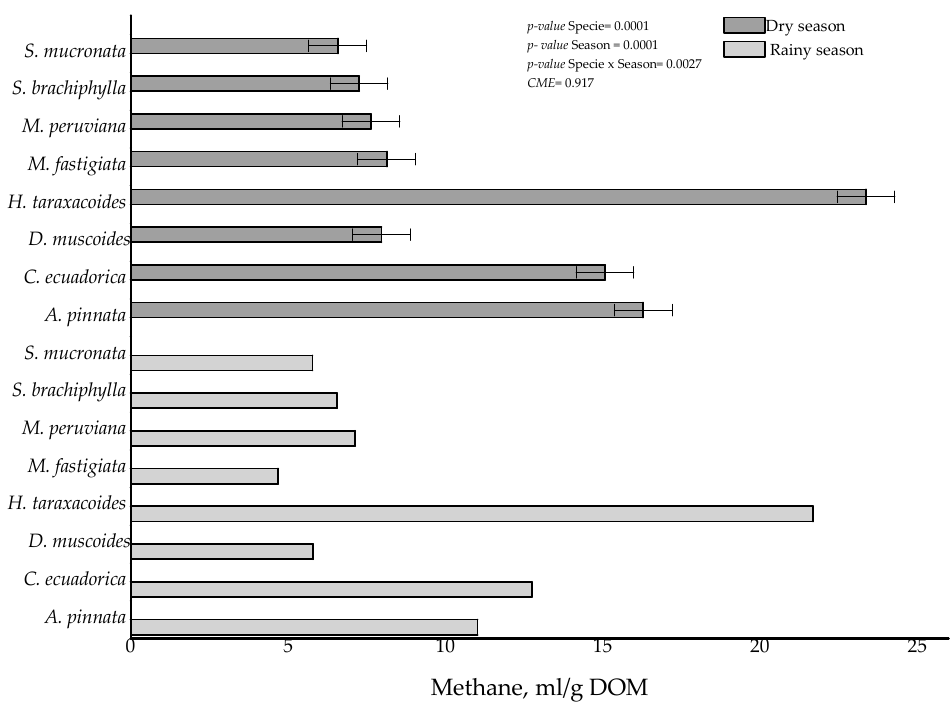
Figure 1. Methane production (mL) per gram of degraded organic matter (DOM) of high Andean grasses in the rainy and dry seasons.